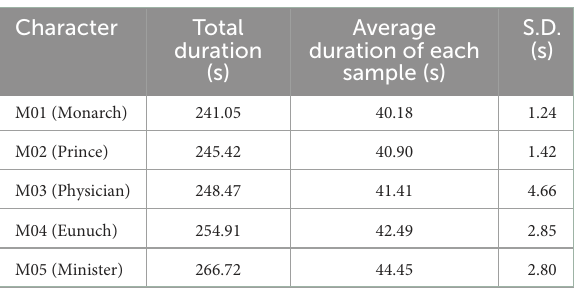
TABLE 2 Duration of the sentence samples of each character (two decimal